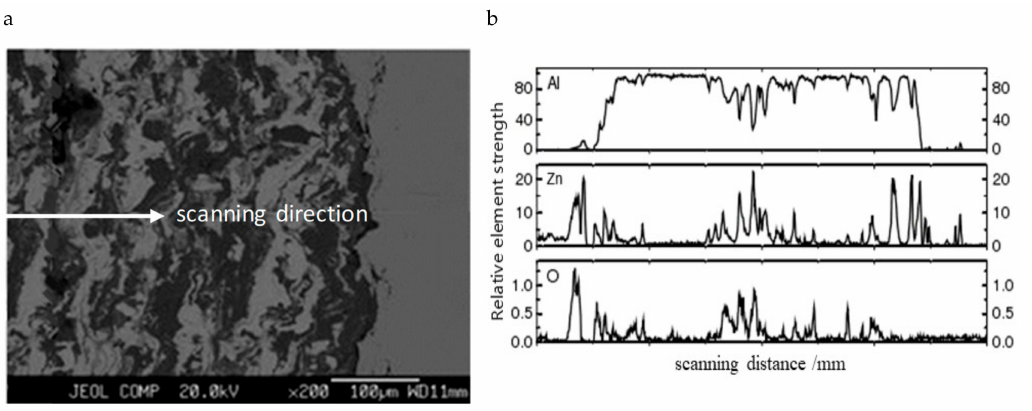
Figure 3. EMPA analysis of ( a ) scanned image and ( b ) analysis results.